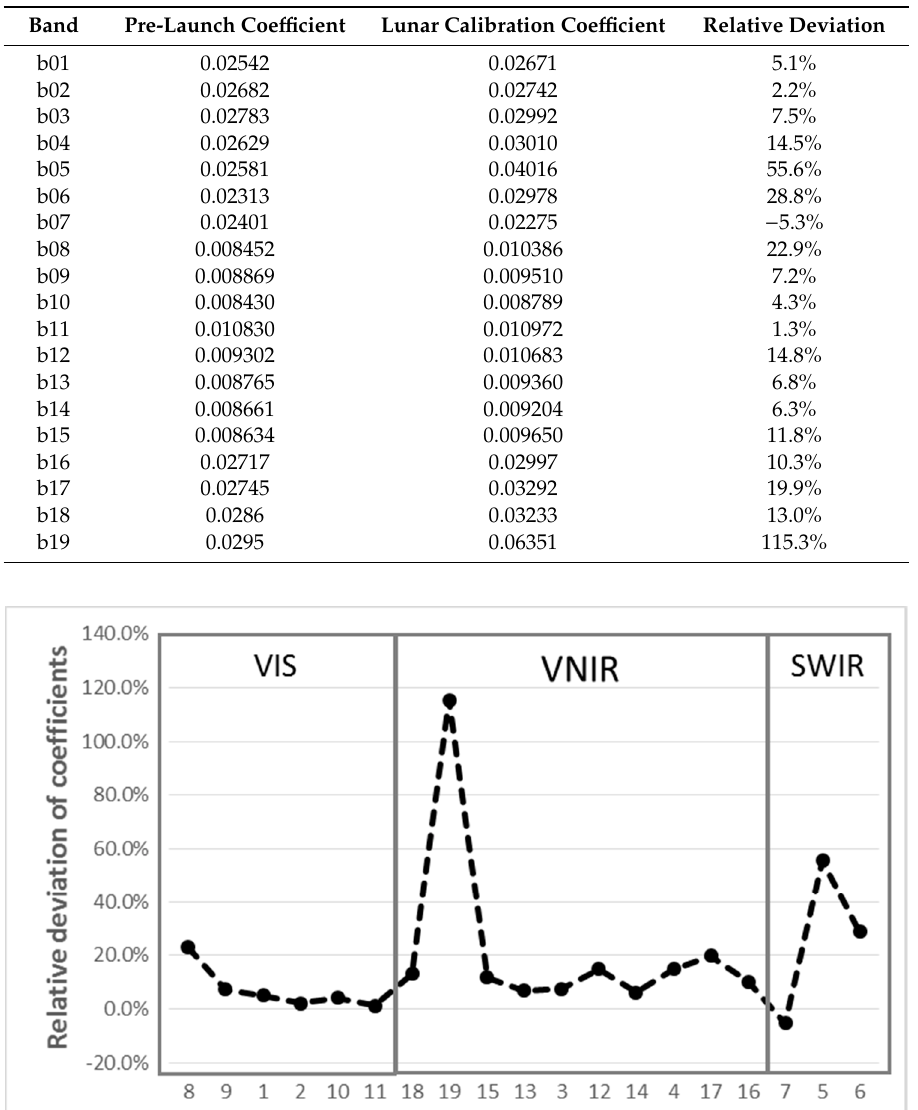
Table 4. Calibration coe ffi cient based on lunar calibration and prelaunch laboratory calibration.